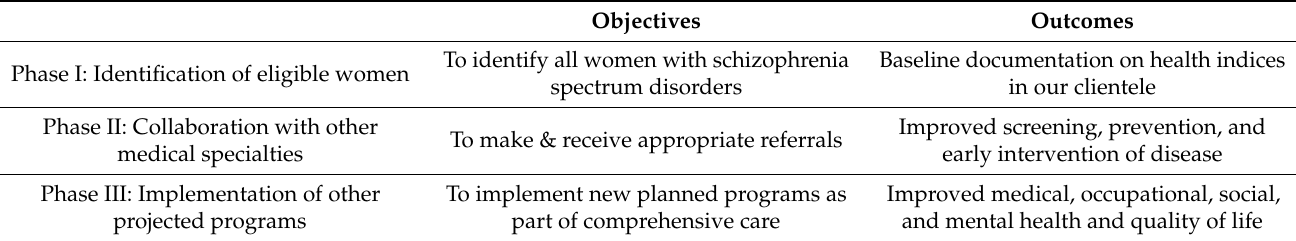
Table 2. Phases of implementation of the unit for women with schizophrenia.